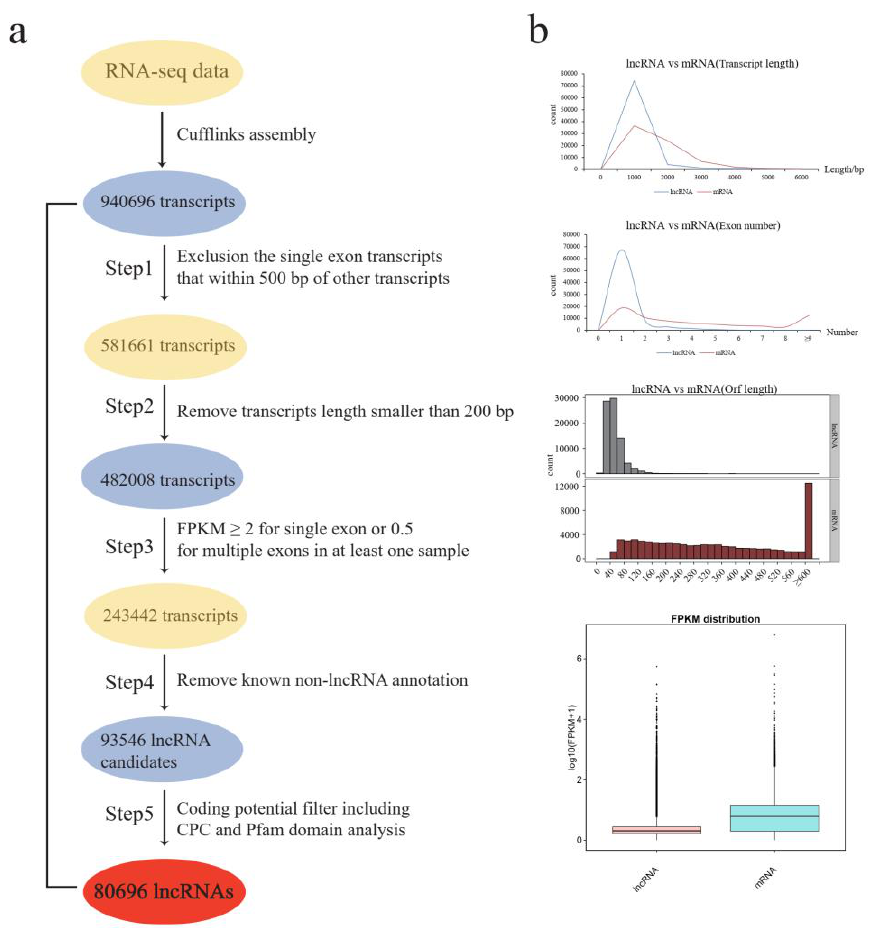
Figure 1. Identification and characterization of long noncoding RNAs (lncRNAs) in Gossypium hirsutum . ( a ) The pipeline for the identification of lncRNAs in Gossypium hirsutum ; ( b ) Compare the characteristics of lncRNAs and mRNAs in Gossypium hirsutum .